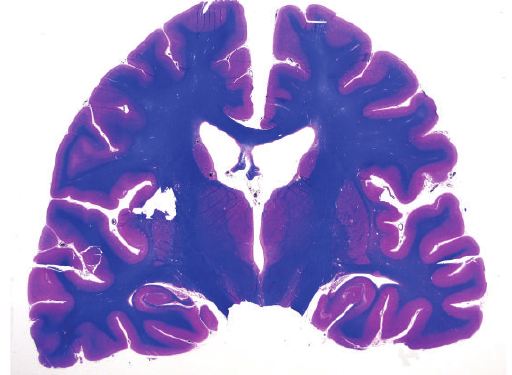
Figure 6: Large format section of brain, stained with the Luxol-fast blue technique, evidence the normal brain anatomical structures.